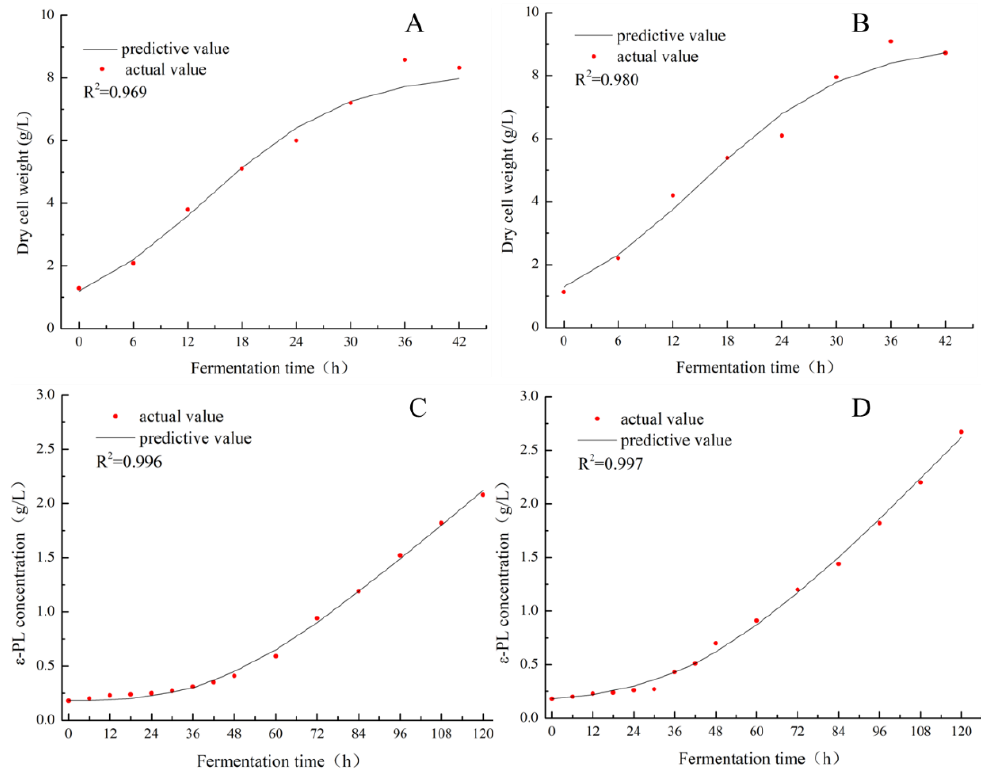
Figure 3. Curve fitting of kinetic model with biomass and ε -PL of S.albulus under ultrasound (( A ) DCW; ( B ) ε -PL concentration) and without ultrasound (( C ) DCW; ( D ) ε -PL concentration).